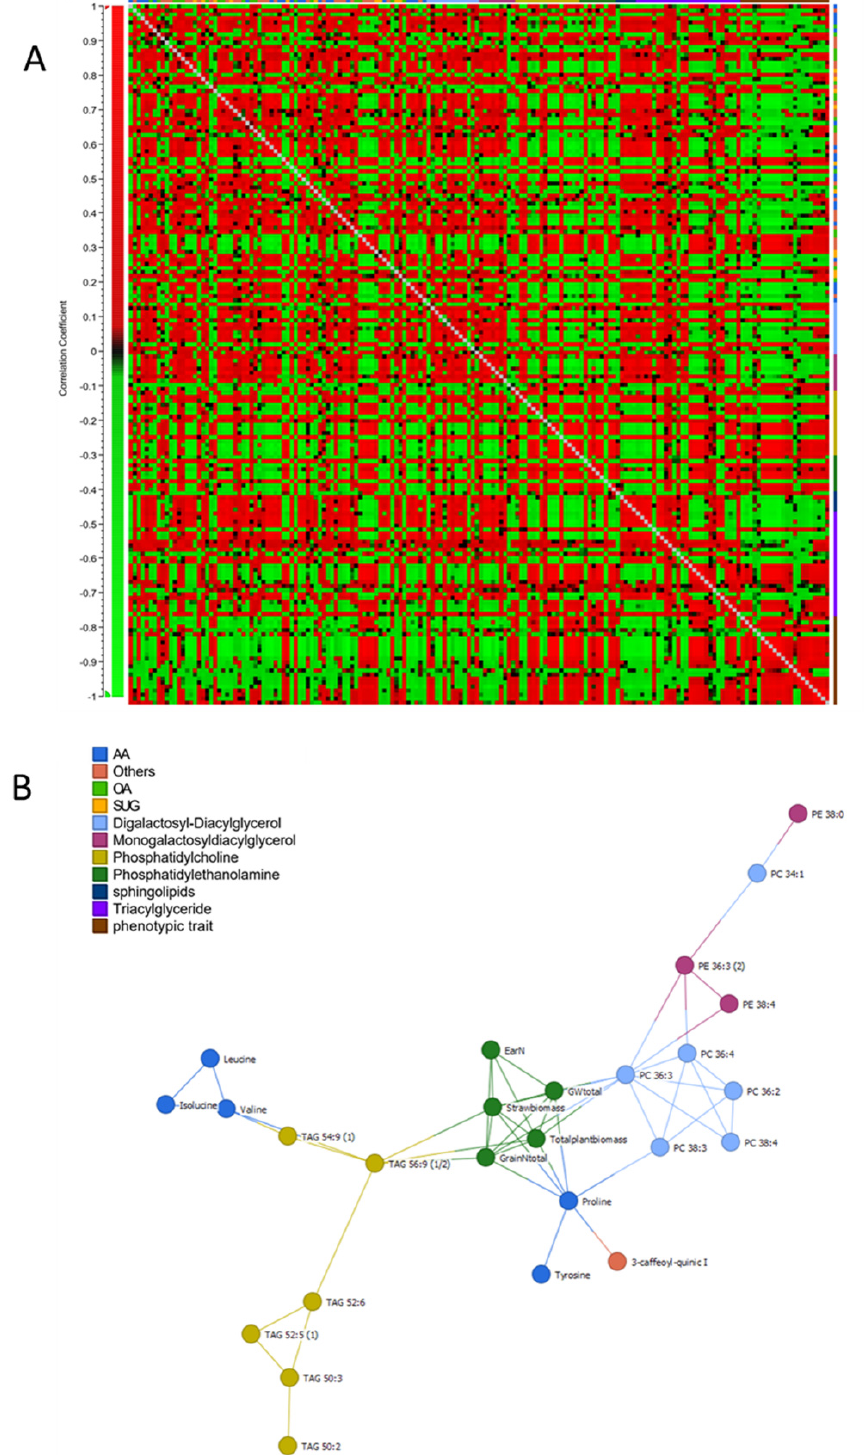
Figure 7. ( A ) Correlation analysis between and within phenotypic and metabolic traits. ( B ) Plan showing correlation network analysis with ≥ 90%, each node represents a metabolite or a plant phenotypic trait, edges connecting two nodes show an association between two traits. Full data represent in Table S3.